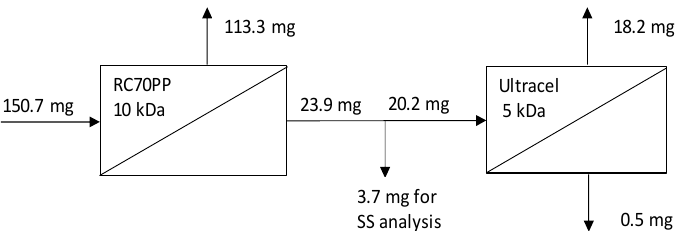
Figure 6. Mass balance of precipitated lignin (precipitation by water addition) for the two-pass membrane filtration process of 60 vol% spent DES in ethanol purification.